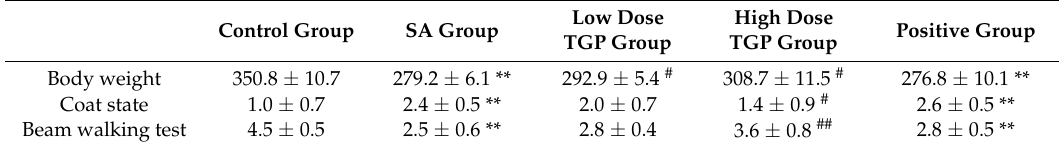
Table 2. Results of physical and behavioral testing measured in each